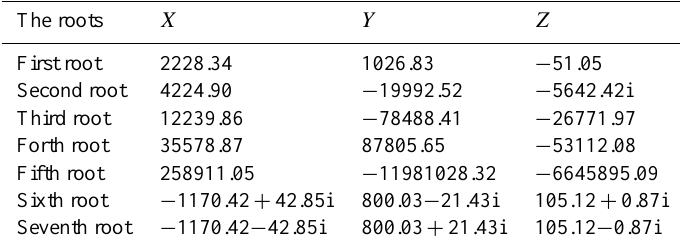
Table 2. The equilibrium roots of the summer SH equations in 2006. The roots X Y Z First